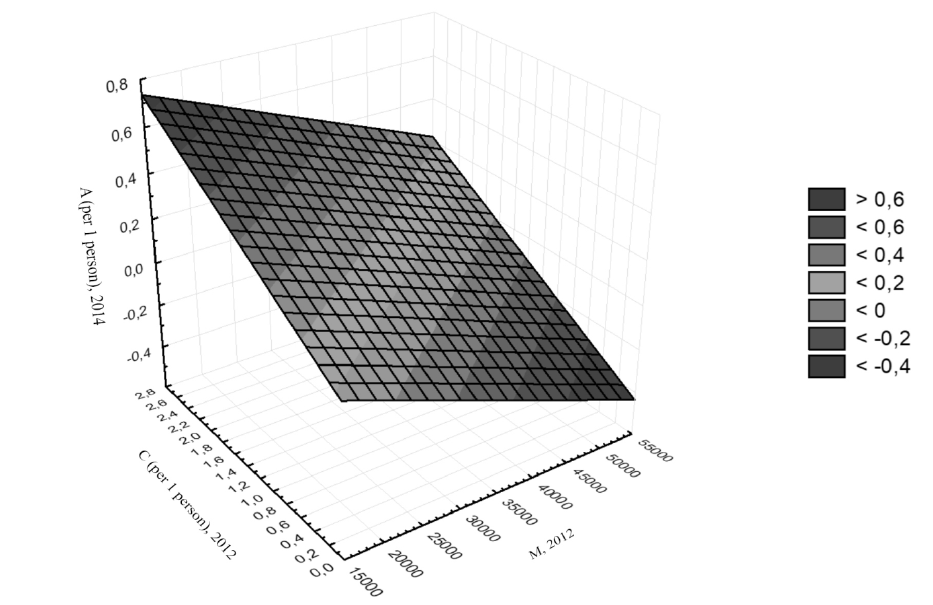
Figure 2. Three-dimensional graph built on the results of the regression model shown in Table 2